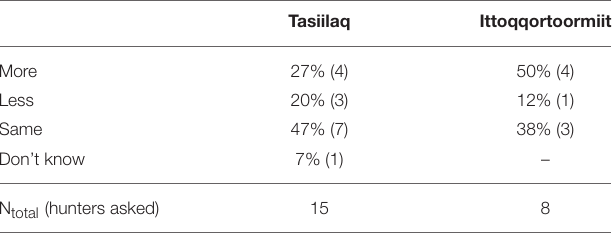
Number in parentheses corresponds to the number of hunters who selected each response. Percentages are rounded to nearest integer. See Supplemental Material for full list of interview